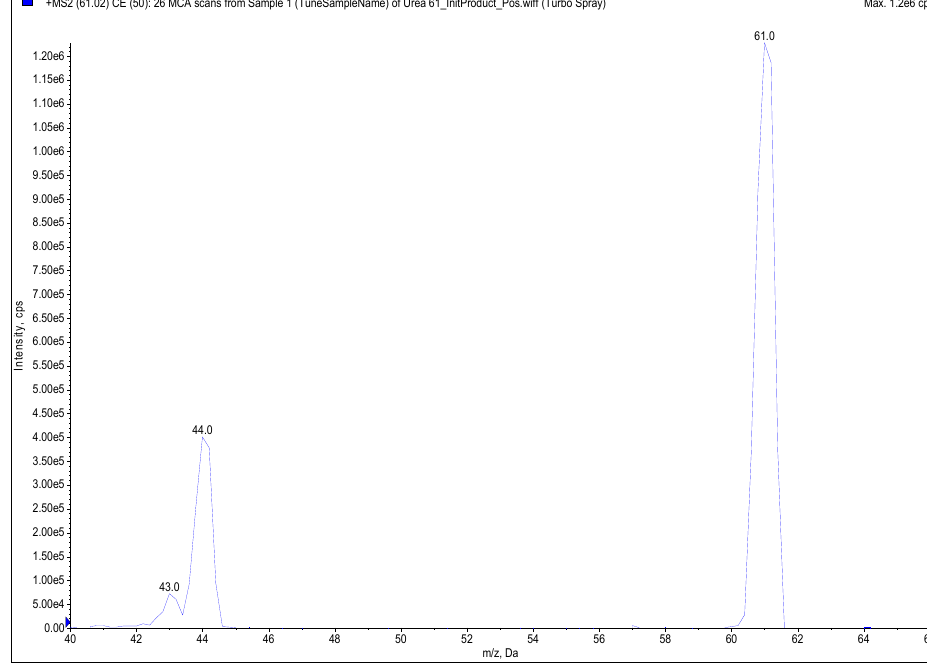
Figure 6. Multiple reaction monitoring (MRM) analysis for detection and quantitation of urea by triple quadrupole mass spectrometry coupled with Electrospray Ionization (ESI) in positive ion mode with transition m / z (61 → 44).